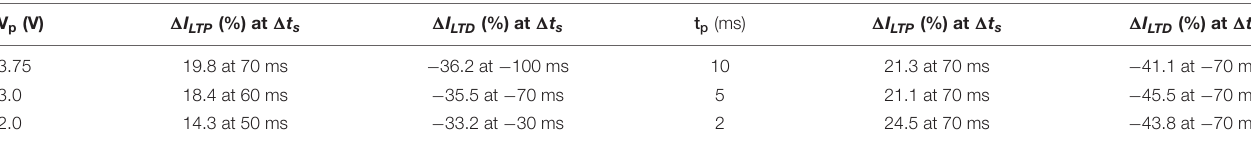
FIGURE 3 | Comparison of STDP diagrams (A) with different pulse amplitudes V p = 3.75 V (square), 3 V (triangle), and 2 V (circle) and same pulse width t p = 10 ms (i.e., learning window of τ = 25 ms) and (B) with different pulse width t p = 10 ms (square), 5 ms (triangle), 2 ms (circle) and the same pulse amplitude V p = 3.75 V. The measurement waiting time is defined as t w = 2 s. The inset of panel (A) shows the length of learning windows in dependence of the pulse amplitude V p , and the inset of panel (B) shows the length of learning windows in dependence of pulse width t p . TABLE 1 | The saturated (cid:49) I LTP / (cid:49) I LTD in the saturation region (from | (cid:49) t s | up to 10 * t p ) recorded upon the application of potentiation/depression spike sequence with different pulse amplitudes of V p = 3.75, 3.00, and 2.00 V ( t p is kept constant as 10 ms) or with t p = 10, 5, and 2 ms ( V p is kept constant as V p = 3.75